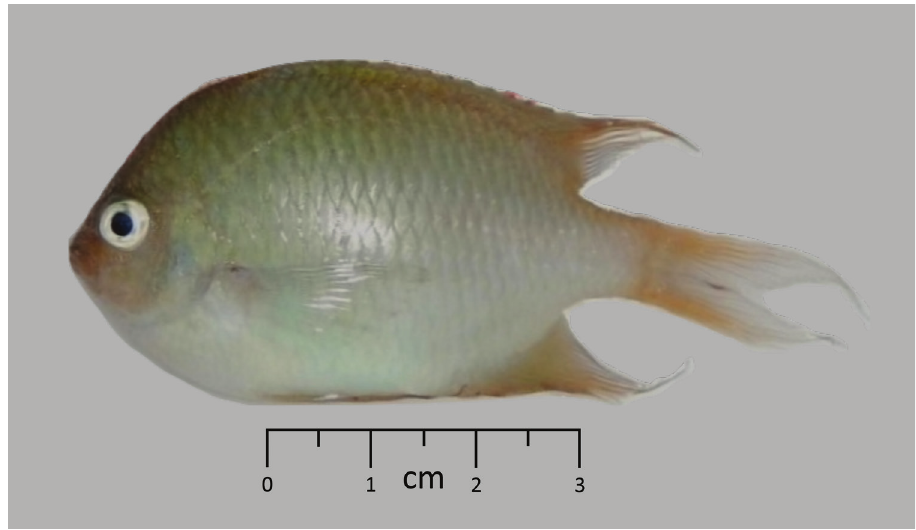
Figure 1. Holotype of Altrichthys alelia , shortly after capture. Photo by Gary C.